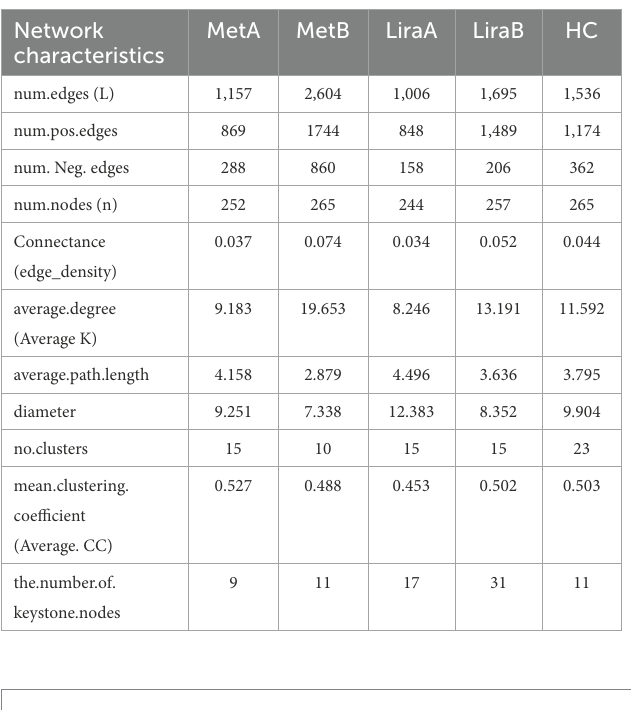
TABLE 2 Topological characteristics of intestinal bacterial community network before and after metformin or liraglutide treatment and in healthy controls.